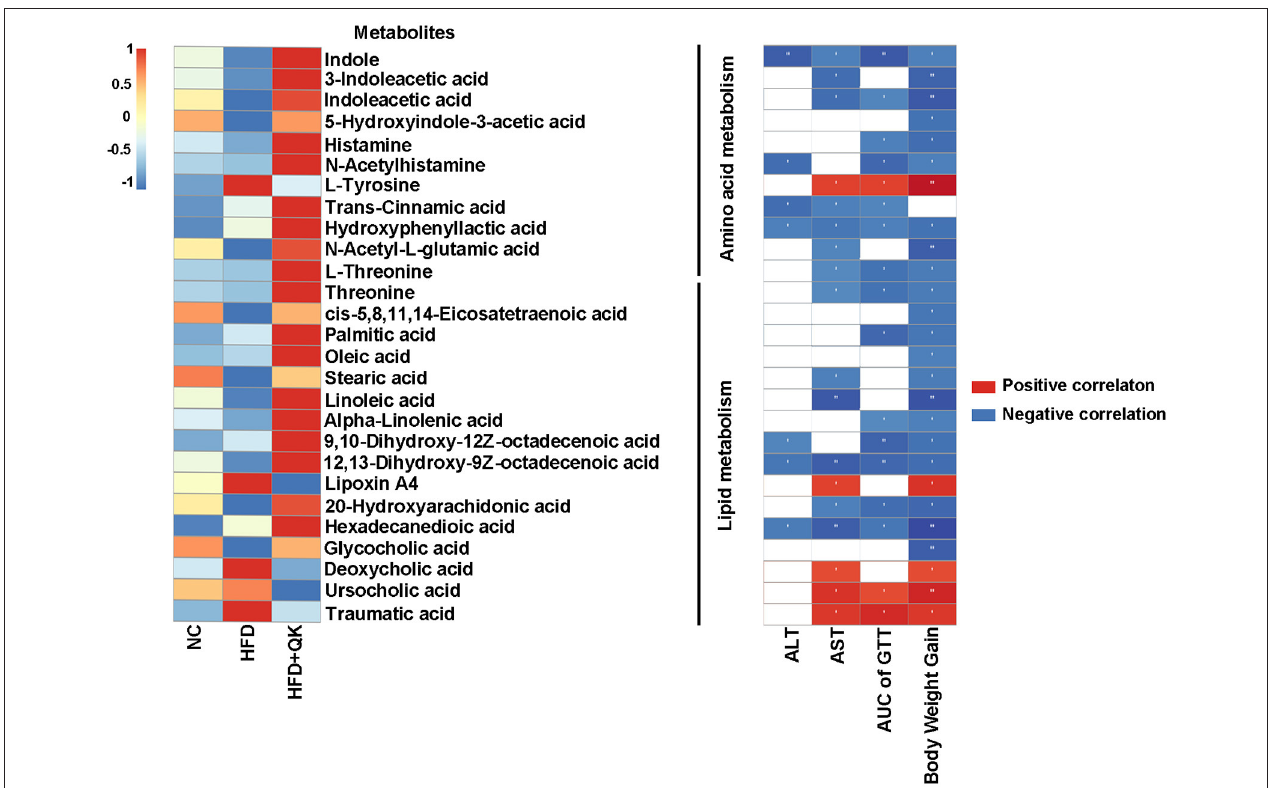
FIGURE 7 | Correlation between metabolites and host parameters related to glucose and lipid metabolism. Left, heat map of metabolites involved in amino acid and lipid metabolism. Right, Spearman correlations between the abundance of these metabolites and the host parameters related to obesity. Red indicates positive correlation and black indicates negative correlation, the darker the color, the stronger the correlation, * p < 0.05, ** p < 0.01.